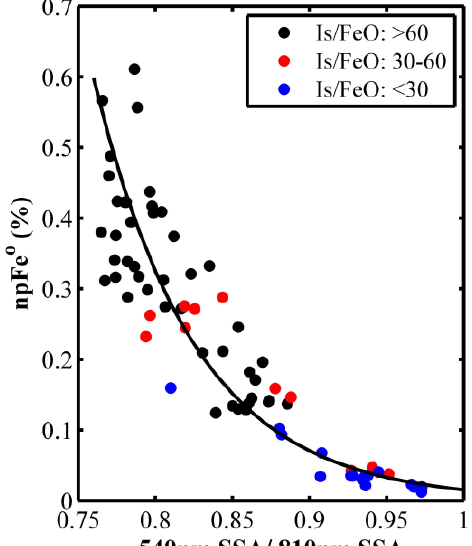
Figure 5. Correlation between the ratio of 540 nm SSA / 810 nm SSA and npFe 0 . Di ff erent solid color circles represent di ff erent maturity groups (I s / FeO) of LSCC lunar samples. The black line is the regression line defined in Figure